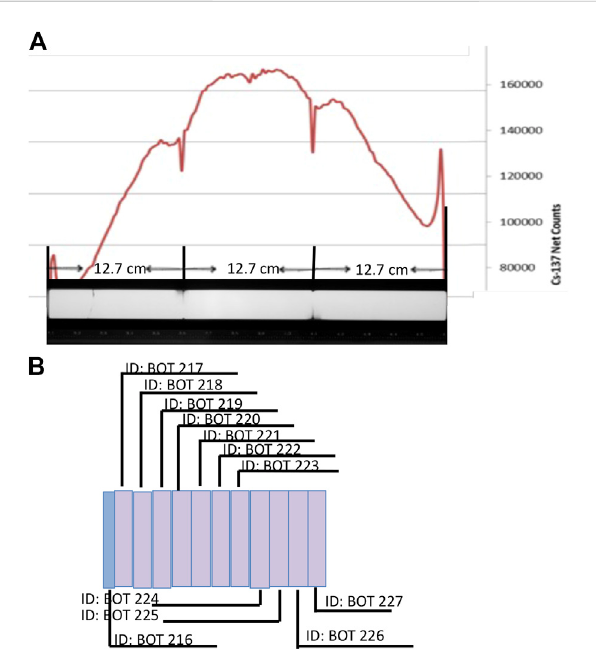
Neutron radiography image (A) showing fuel pellets in fuel rod 10172 and a gamma scanning pro fi le for 137 Cs along the length of the fuel rod, which shows how the middle fuel pellet received the highest burnup during irradiation. The schematic diagram in (B) shows how the middle fuel pellet was sectioned to produce samples for analytical chemistry, gamma scanning tomography, and microstructural characterization.